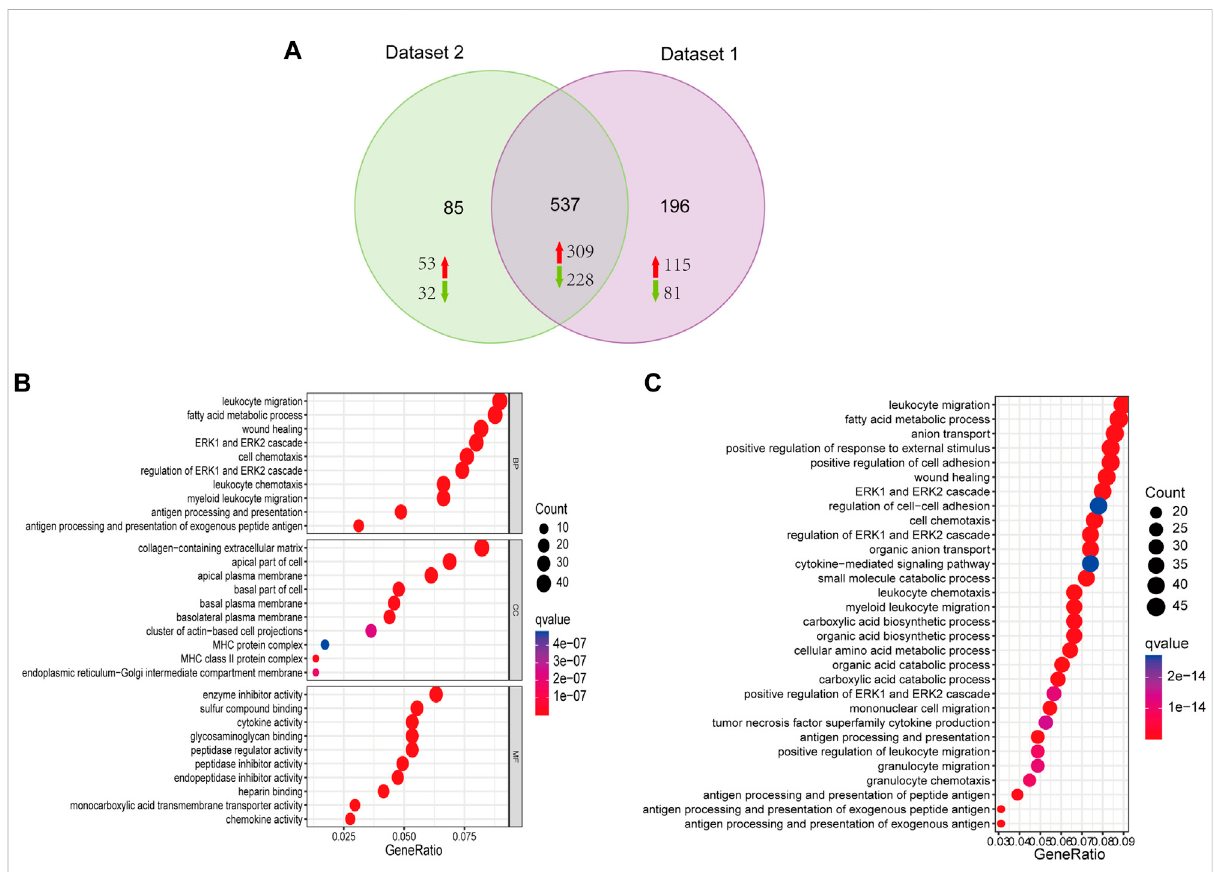
FIGURE 3 Functional analysis of DEGs. (A) Venn diagram showing the 537 shared DEGs from the two datasets, including 309 upregulated and 228 downregulated genes. (B) Biological process (BP), cellular components (CC), and molecular function (MF) are the components of GO enrichment analysis results, and each part displays the top ten GO terms. (C) KEGG pathway enrichment of